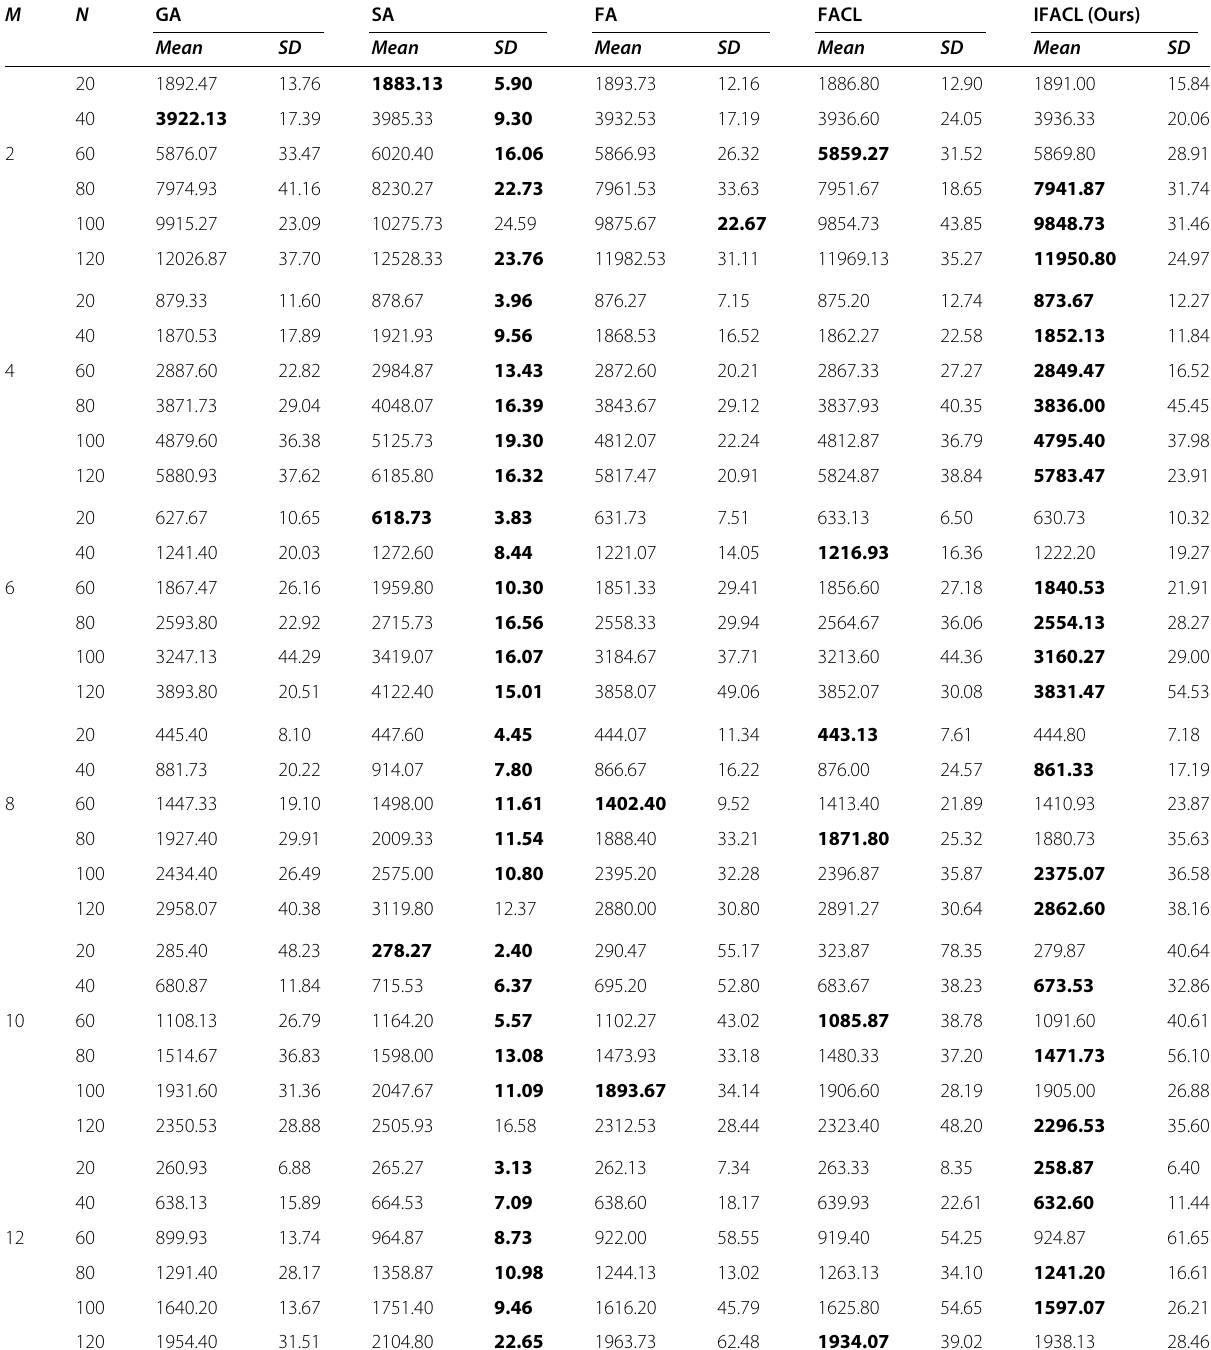
Table 8 Comparison between IFACL algorithm and four comparison algorithms in SDominant instances on